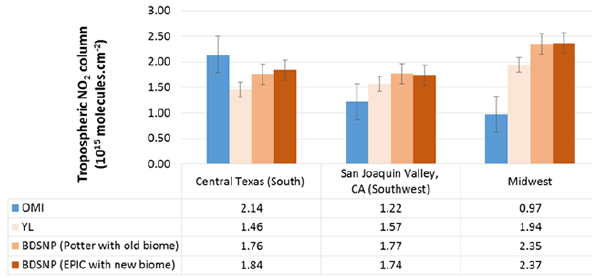
Figure 7. Spatial average for Tropospheric NO 2 (moleculescm − 2 ) over regions with high soil NO sensitivity with switch from YL to BDSNP (as in Fig. 6) with comparison to OMI NO 2 . NO 2 column are temporal average for July 2011 at OMI overpass